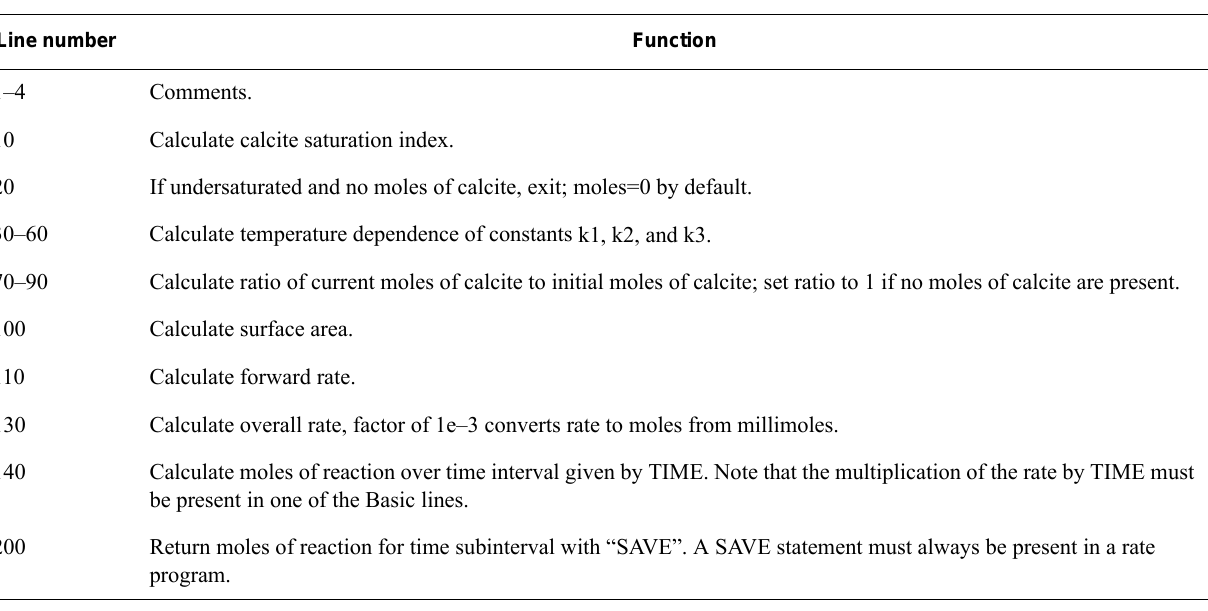
Table 5. Description of Basic program for calcite kinetics given in example for RATES data